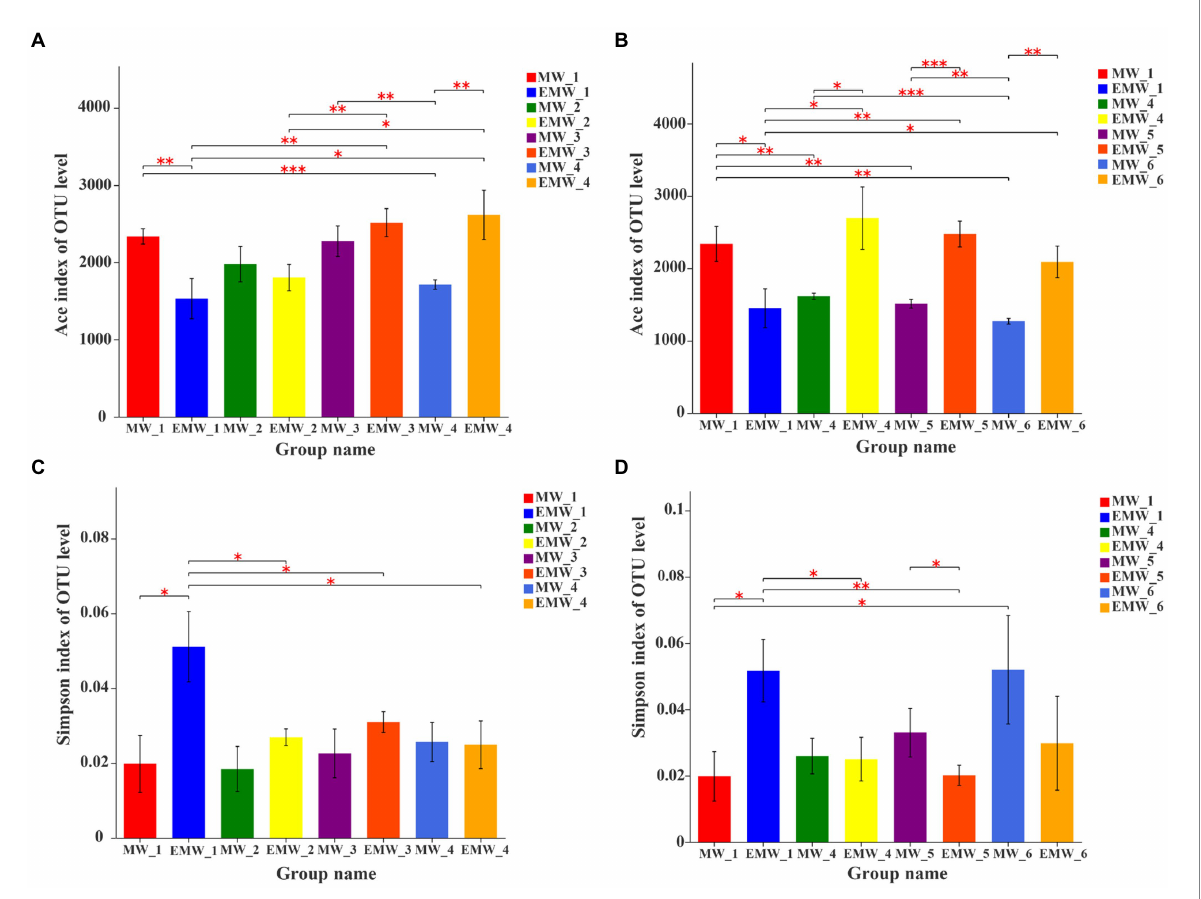
FIGURE 4 Alpha diversity estimates of the microbial communities at the OTU level in M and EM groups. (A) ACE index (the first month), (B) ACE index (3 months), (C) Simpson index (the first month), and (D) Simpson index (3 months). * p < 0.05; ** p < 0.01; *** p <